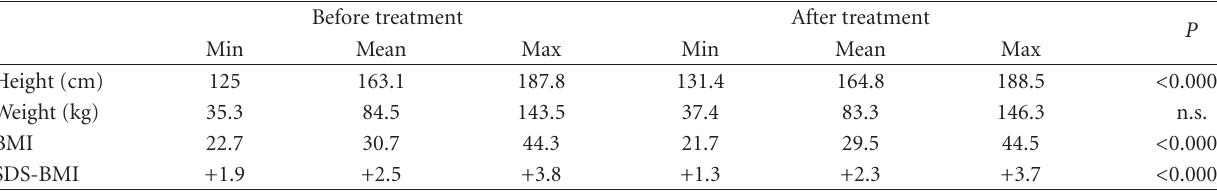
Table 1: Anthropometric data of the study group before and after participation in the obesity intervention program.